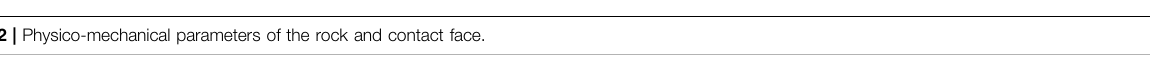
TABLE 2 | Physico-mechanical parameters of the rock and contact